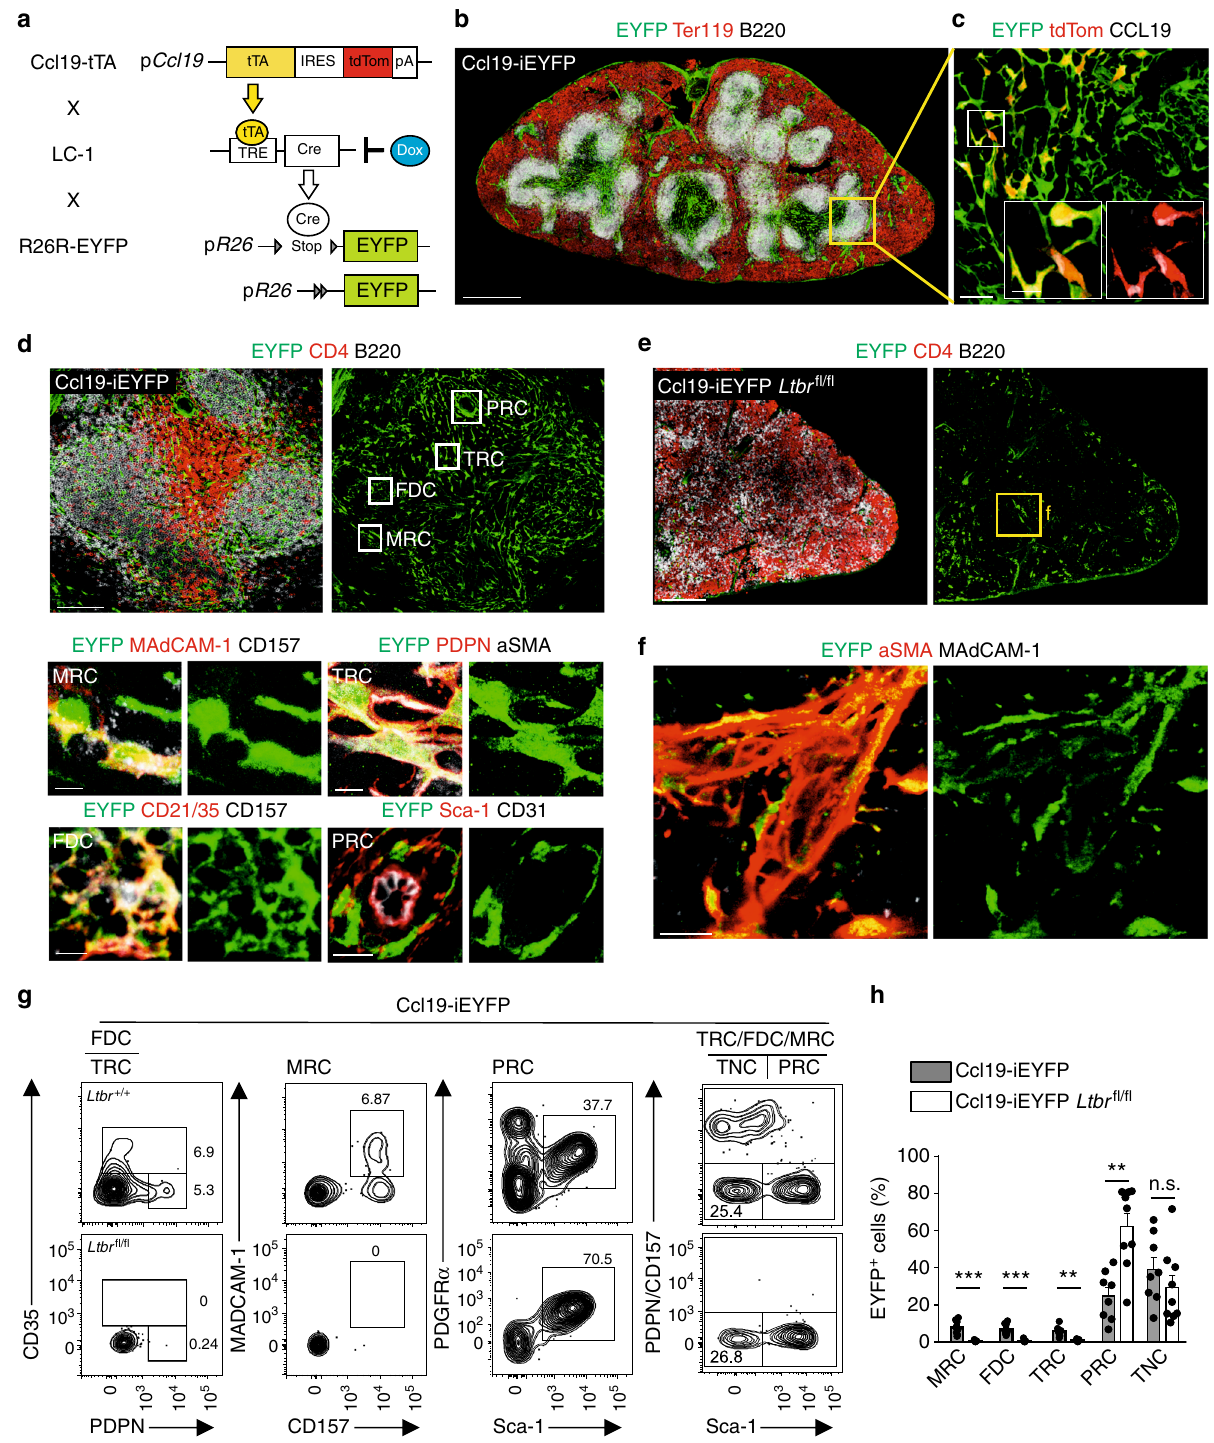
cell type-speci fi c lack of Ltbr expression (Fig. 1g, h). In sum, these results indicate that mLTo cells are speci fi cally targeted in the Ccl19-iEYFP transgenic mice and suggest that the LT β R- dependent emergence of distinct reticular cell subsets facilitates the organization of the splenic white pulp. De fi ning the mLTo cell habitat in the embryonic spleen . Timed pregnancy and assessment of transgene activity at different embryonic stages in Ccl19-iEYFP mice revealed that α SMA-